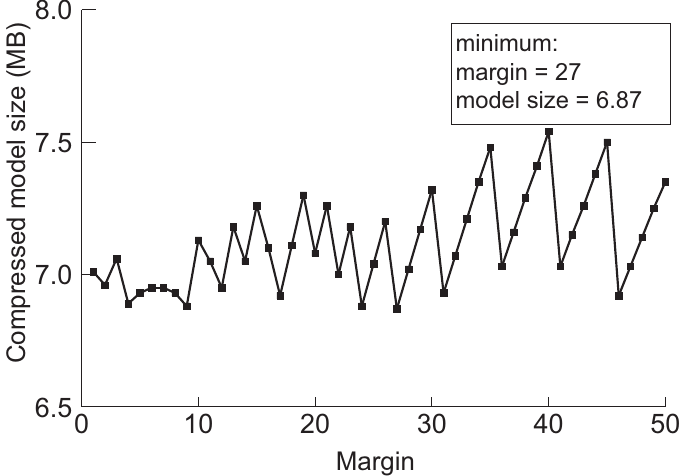
Figure 10. The minimum model sizes derived by the proposed method when the initial margin is varied from 1 to 50 for DenseNet-202 when the target accuracy is